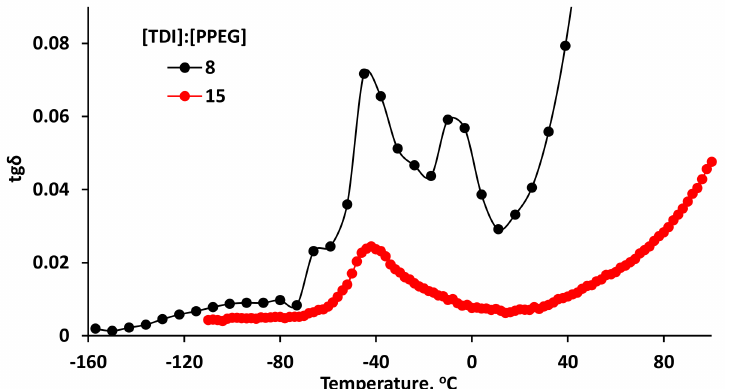
Figure 11. Temperature dependences of the dielectric loss tangent of polymers based on